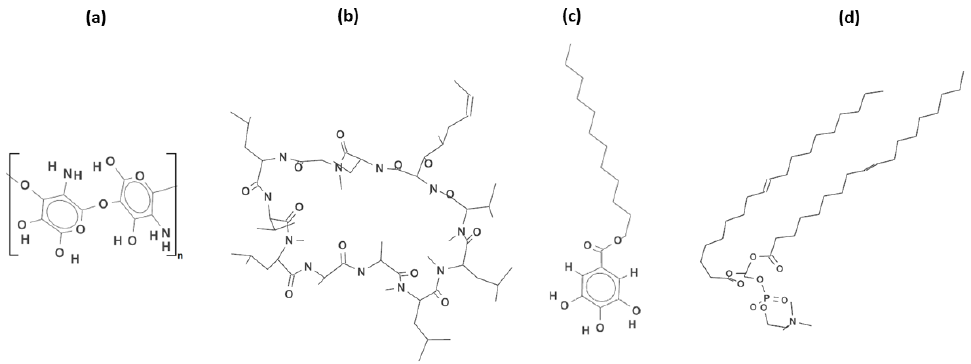
Figure 1. Chemical structure of chitosan monomer (Ch) ( a ), cyclosporine A (CsA) ( b ), lauryl gallate (LG) ( c ) and 1,2-dioleoyl- sn -glycero-3-phosphocholine (DOPC) ( d ).